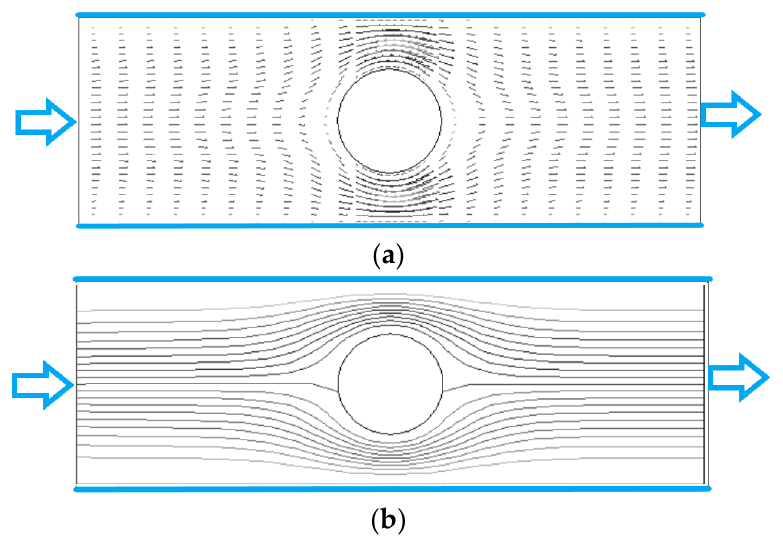
Figure 3. Fluid velocity vector and streamline of flow (Re = 2, n = 0.7). ( a ) velocity vector. ( b ) streamline.